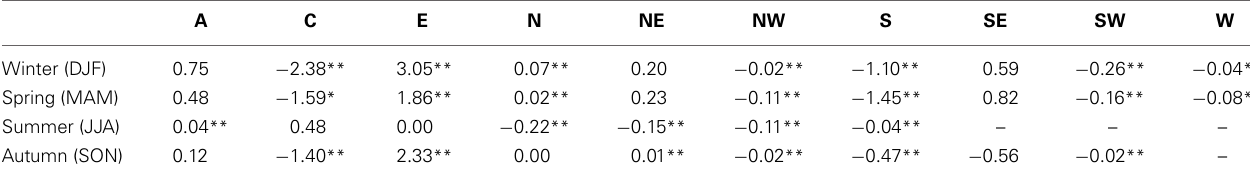
Table 2 | Linear trends of the defined weather types using the SLP fields from the NCEP/NCAR reanalysis data. A C E N NE